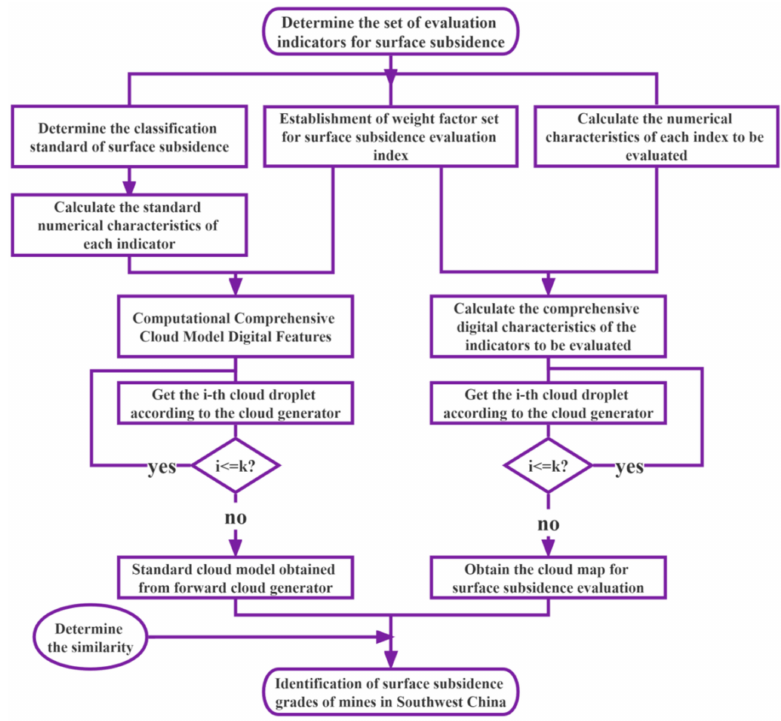
Figure 3. Evaluation process for surface subsidence grade cloud model.